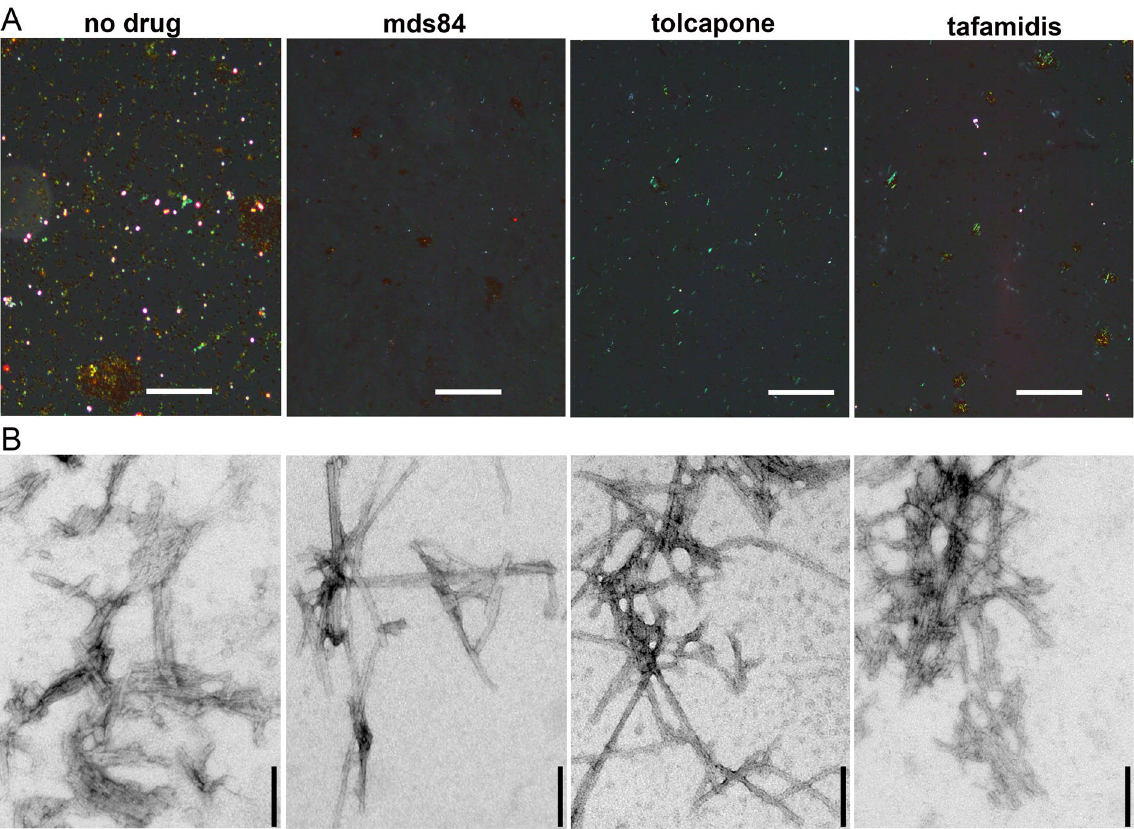
Figure 3. Residual amyloid aggregates in the presence of excess of ligands. ( A ) Congo-red stained specimens viewed under intense cross polarized light in the absence of any ligands and in the presence of fourfold molar excess of mds84, tolcapone and tafamidis (Supplementary Fig. S6). Some fragments of amyloid are present with maximally inhibitory ligand concentrations (Fig. 1), although least with mds84. Scale bar, 100 µ M. ( B ) Typical fibrillar structures detected by exhaustive analysis of negatively stained electron microscopy images of the same TTR-ligand preparations. Scale bar, 100